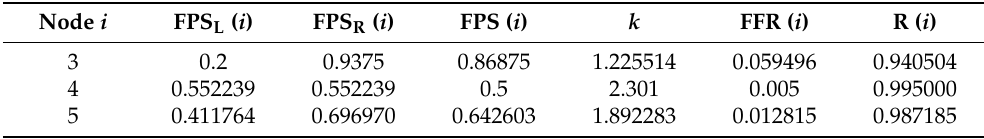
Table 7. Example of STEPs P3 and